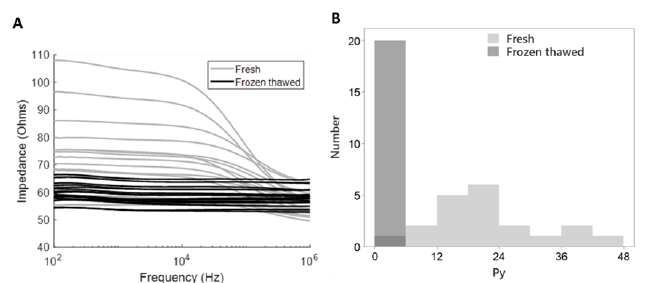
Figure 2. Individual impedance response spectra and P y values indicate almost complete separation of refrigerated and subsequently frozen-thawed pork samples (N=20 for each test group and one specific electrode position). A. Impedance spectra before freezing (refrigerated) and after thawing (frozen-thawed). B. Histogram plot of P y values for all pork sirloin samples, as extracted from one specific position measurement.